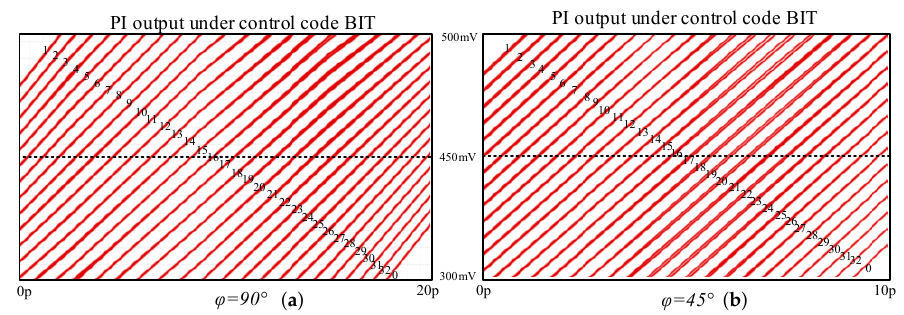
Figure 20. PI output under control code BIT. ( a ) is PI output under control code BIT when ϕ d = 90 ◦ , ( b ) is PI output under control code BIT when ϕ d = 45 ◦ .